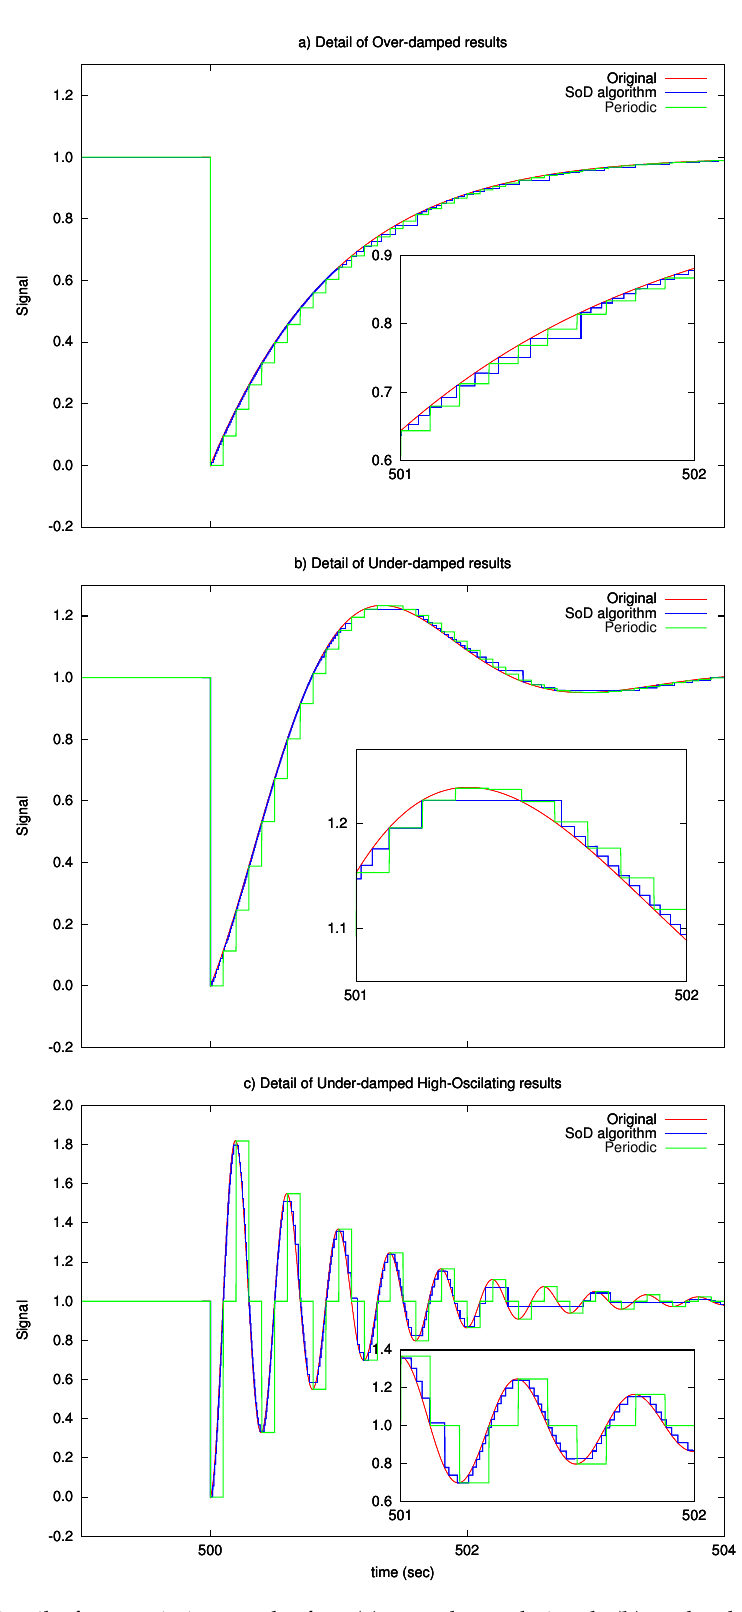
Figure 3. Detail of transmission results for: ( a ) over-damped signal; ( b ) under-damped signal; ( c ) under-damped High-Oscillating